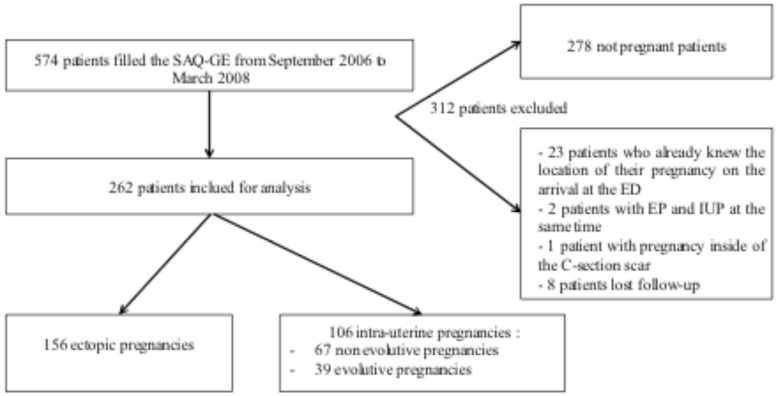
Flow Chart.SAQ-GE, self-assessment questionnaire for gynecological emergencies; EP, ectopic pregnancy; IUP, intra-uterine pregnancy.